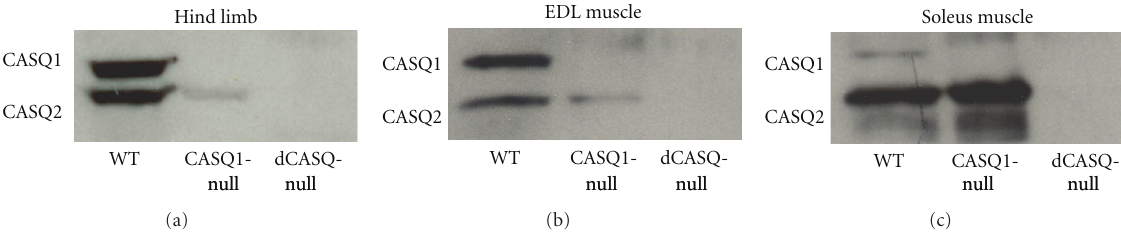
Figure 1: dCASQ-null mice did not express any of the two CASQ isoforms. Western blot analysis of total homogenates prepared from hind limb (a), EDL, and Soleus (b and c) muscles showed that (i) in CASQ1-null muscles CASQ1 was missing, whereas CASQ2 was still present, more in Soleus (slow twitch) and less in EDL (fast twitch); (ii) in dCASQ-null muscles both isoforms were absent.